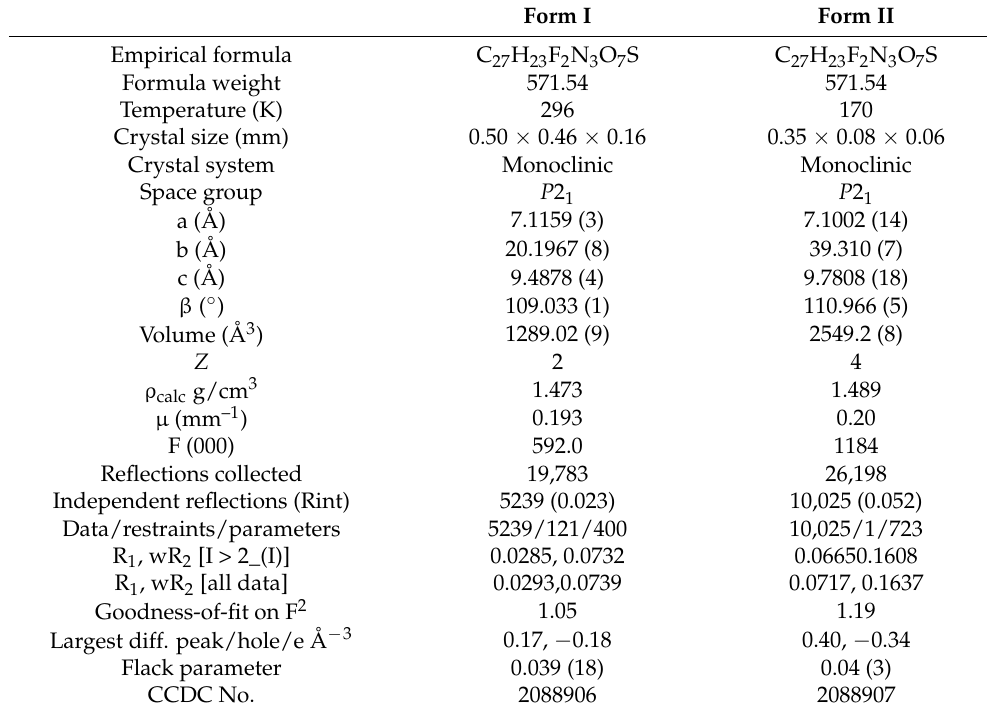
Table 1. Crystallographic data of Form I and